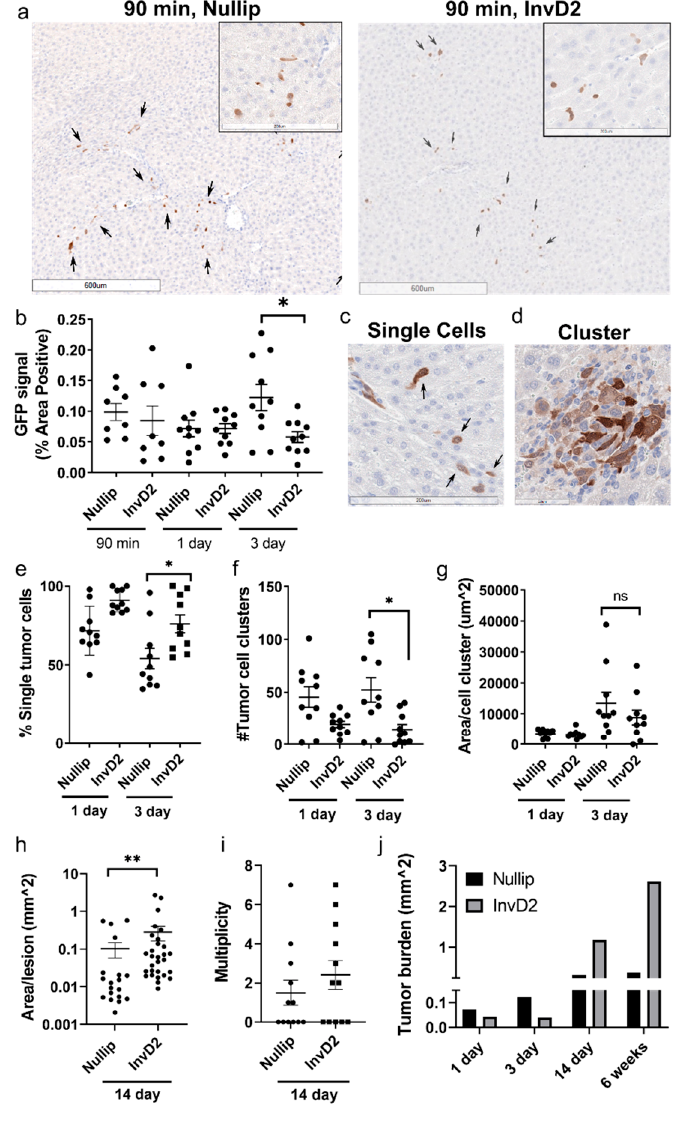
Figure 3. Involution metastatic advantage is observed by 2 weeks post-injection but not at earlier time points. ( a ) Representative low and high magnification IHC images of liver FFPE sections stained to identify GFP-tagged D2.OR cells, arrows indicate tumor cells; ( b ) IHC quantification of GFP+ tumor cells in liver FFPE sections from mice euthanized 90 min ( n = 4 mice/group), 1 day ( n = 5 mice/group), and 3 days ( n = 5 mice/group) after intraportal injection of 500,000 D2.OR-GFP tumor cells per liver. Two sections >200µm apart were assessed per mouse to quantify independent tumor cells; One-way ANOVA; Representative high magnification images showing GFP+ tumor cells as ( c ) single cells (1 day time point) or, ( d ) clusters, defined as >3 tumor cells, i.e., micro-metastases, (3 day time point); Quantification of GFP+ ( e ) single tumor cells as a percent of total tumor cell signal, ( f ) number of tumor cell clusters, and ( g ) size of tumor cell clusters at 1 and 3 days post-injection; One-way ANOVA; IHC quantification of GFP+ ( h ) tumor area and ( i ) multiplicity from mice euthanized 14 days after intraportal injection of 500,000 D2.OR-GFP tumor cells; Two-tailed Mann-Whitney test; ( j ) Timeline of tumor burden in nullip (black) and InvD2 (grey) mouse groups, showing “switch” from early (3 day) advantage in nullip to later ( ≥ 14 days) advantage in involution. * p < 0.05, ** p < 0.01.